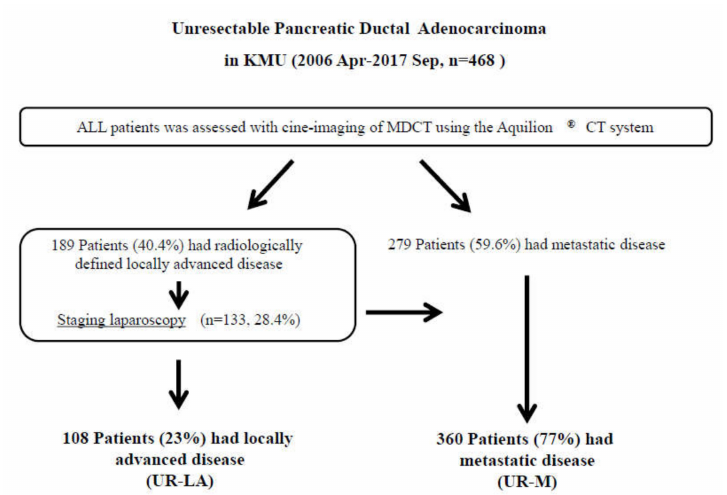
Figure 1. Study flow diagram. Diagnoses were made, using multidetector-raw computed tomography. In total, 189 patients were diagnosed with unresectable locally advanced pancreatic ductal adenocarcinoma (UR-LA PDAC), and 279 patients were diagnosed with unresectable metastatic (UR-M) PDAC. We performed staging laparoscopy for 133 patients with radiologically defined locally advanced disease. We finally enrolled 108 patients with UR-LA PDAC and 360 patients with UR-M PDAC in the present study. Abbreviations: KMU, Kansai Medical University; MDCT, multidetector-raw computed tomography; UR-LA, unresectable locally advanced; UR-M, unresectable metastatic.